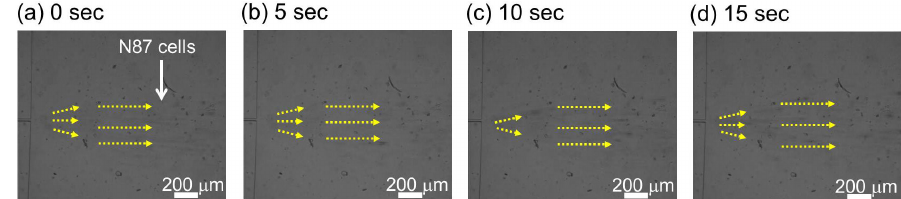
Figure 8. Serial images of N87 cells introduced into a microchamber without a micropillar array. ( a ) N87 cells are introduced. Images at ( b ) 5 s, ( c ) 10 s, and ( d ) 15 s after introduction of the cells. Yellow arrows indicate the direction of cell